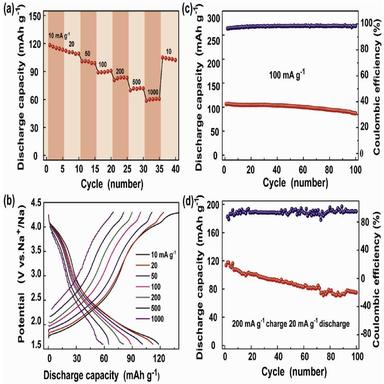
(a) Rate capability from 10 mA g1 to 1000 mA g1 ; (b) Galvanostatic profiles at various current densities (10, 20, 50, 100, 200, 500 and 1000 mA g1 ). (c) Cycling performance of P2-MCC electrode at 100 mA g1 ; (d) Cycling performance at different charge/discharge rates.